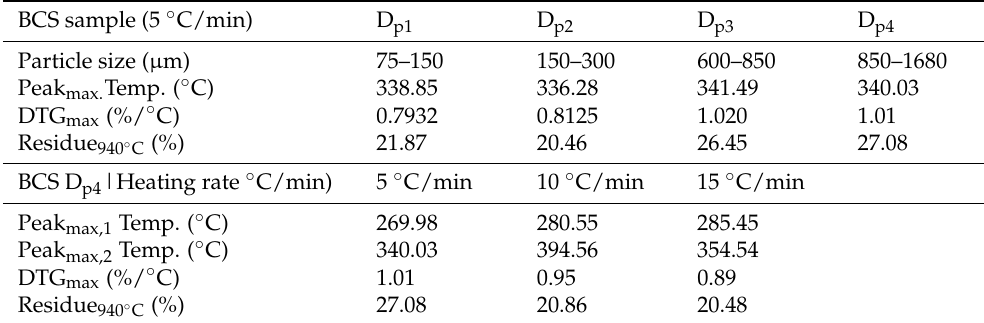
Figure 2. TGA and DTG curves for the pyrolysis of BCS at different heating rates 5, 10, and 15 °C/min and particle size D p4 . Table 2. Peak temperatures and residues of different particle sizes of BCS sample and different heating rates.